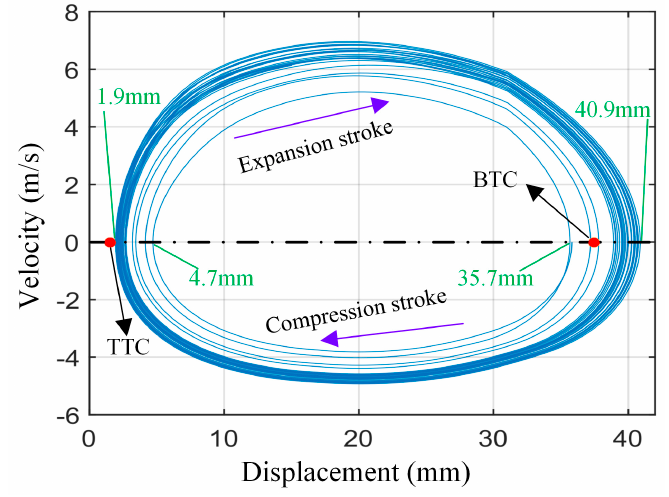
Figure 17. The velocity vs. the displacement (without control).